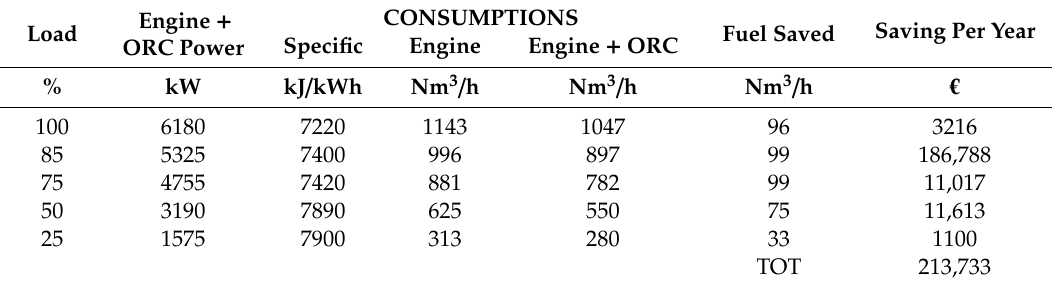
Table 6. Annual savings of the naval ICE with the bottom